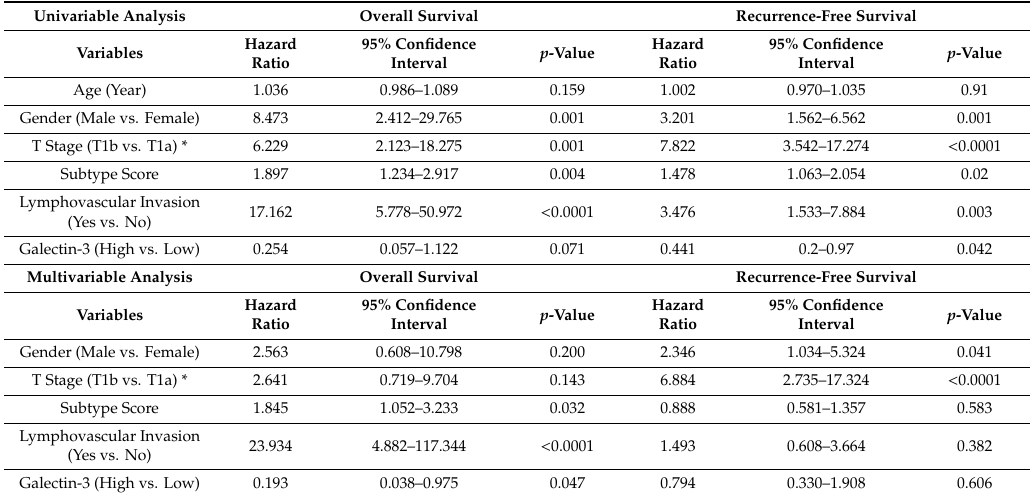
Figure 3. Kaplan–Meier curves of recurrence-free survival in ( A ) T1 lung adenocarcinoma and in ( B ) T1a lung adenocarcinoma. Low: intensity percentage (IP) score < 2; high: IP score ≥ 2. Table 2. Univariable and multivariable analysis for overall survival and recurrence-free